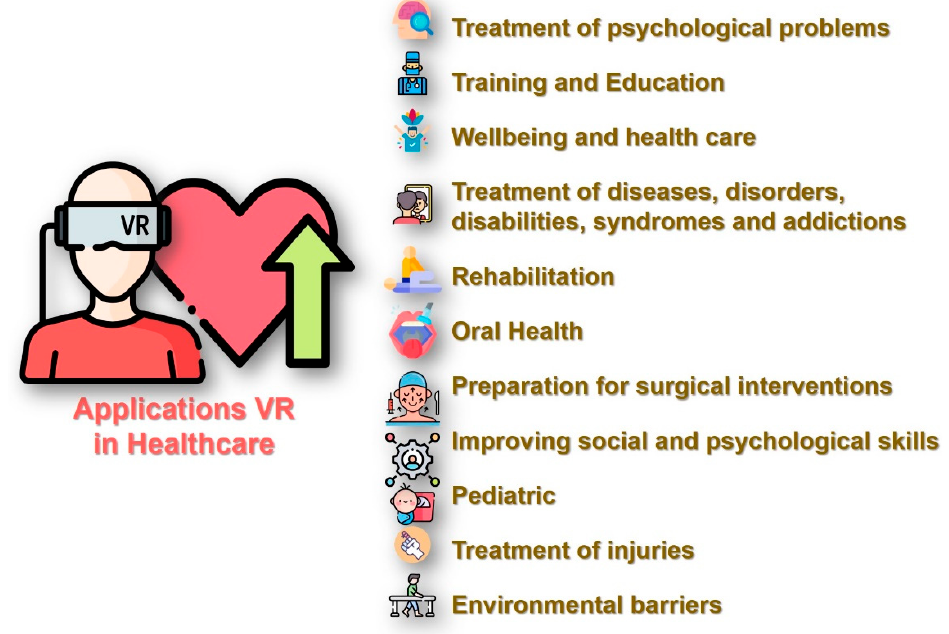
Figure 1. VR applications in healthcare.